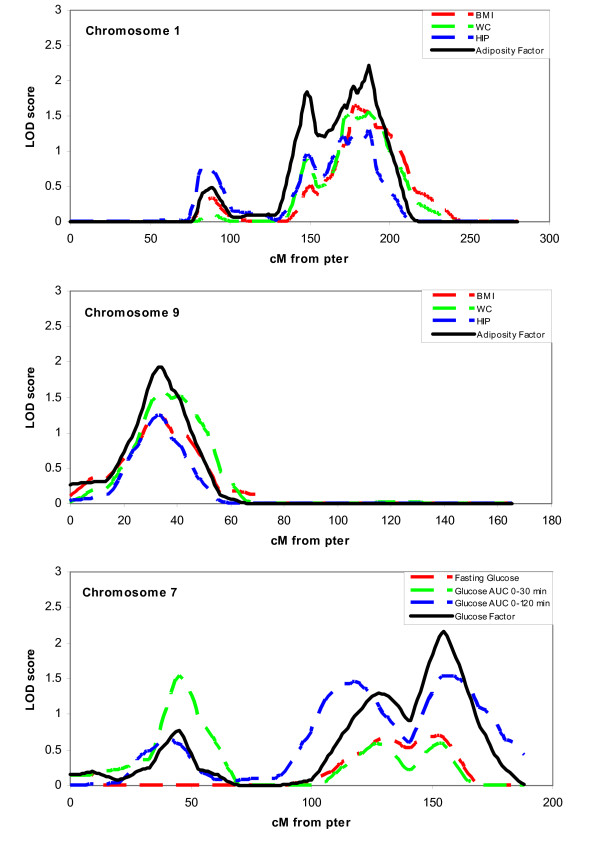
Comparisons of multipoint linkage analyses results for metabolic factors and its individual components. a) Adiposity factor vs BMI, WC and HC on chromosome 1. b) Adiposity factor vs BMI, WC and HIP on chromosome 9. c) Glucose factor vs fasting plasma glucose (PG), PG AUC 0-30 minutes and PG AUC 0-120 minutes on chromosome 7. The horizontal axis is cM from p-terminus.